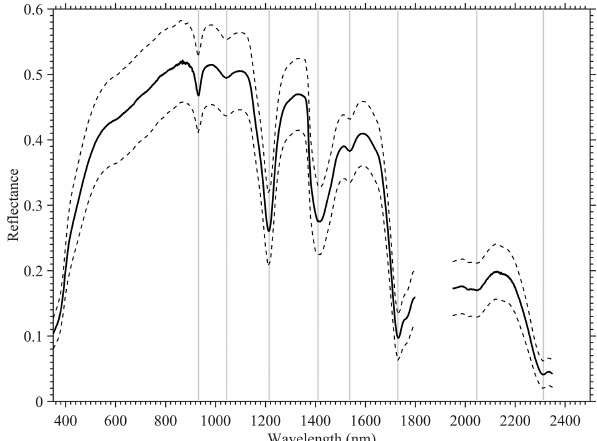
Figure 4. Endmember spectral reflectance of the dry marine- harvested microplastics ± standard deviation (dashed lines). Identi- fied unique absorption features are highlighted by the vertical lines and provide the wavebands that are outlined in grey (centred around ∼ 931, 1045, 1215, 1417, 1537, 1732, 2046 and